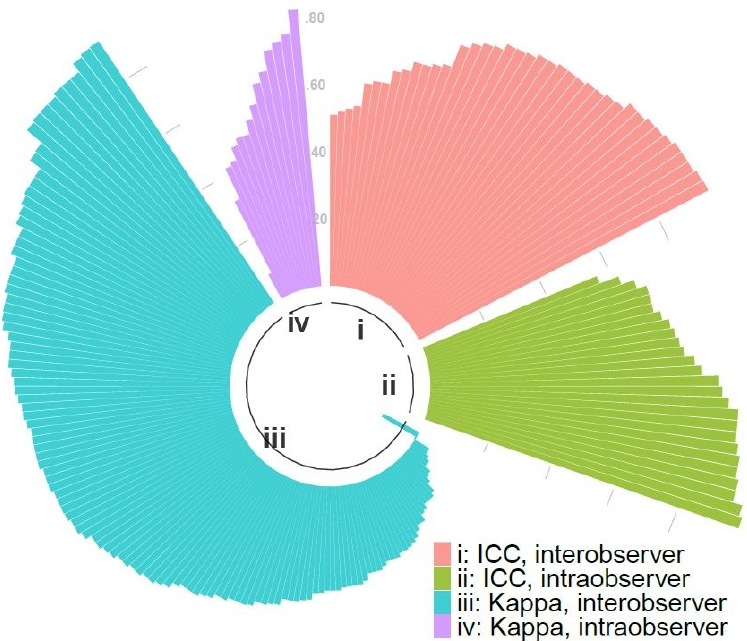
Figure 3. Circle bar chart visualizing the distribution of Kappa statistics and ICC values for every comparison.